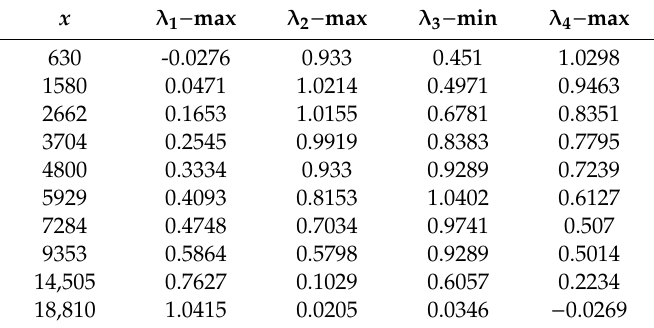
Table 4. Normalized